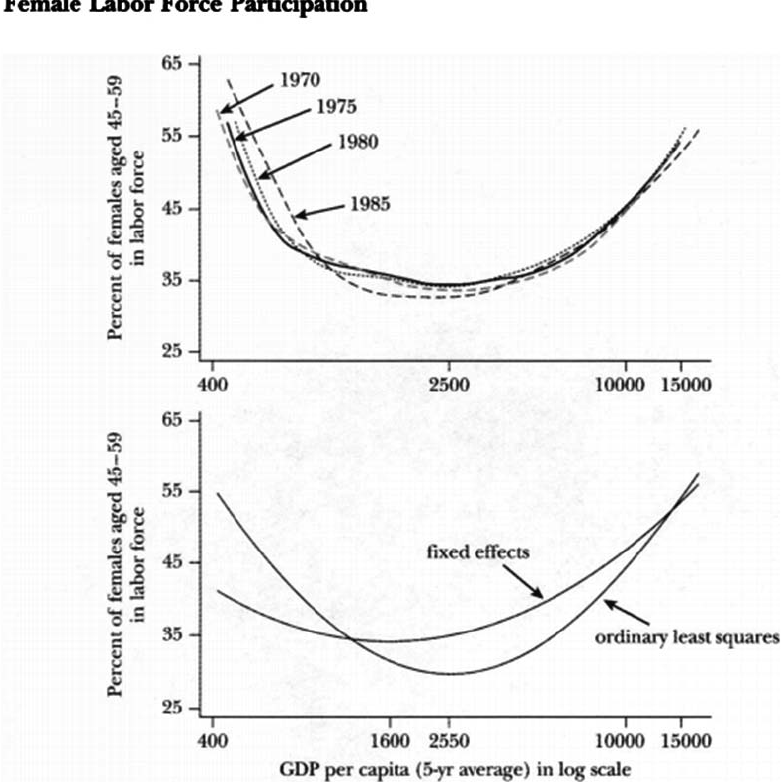
Fig. B1. Distribution shape of female participation in labour force (for females aged 45–59, but still true for other ages).